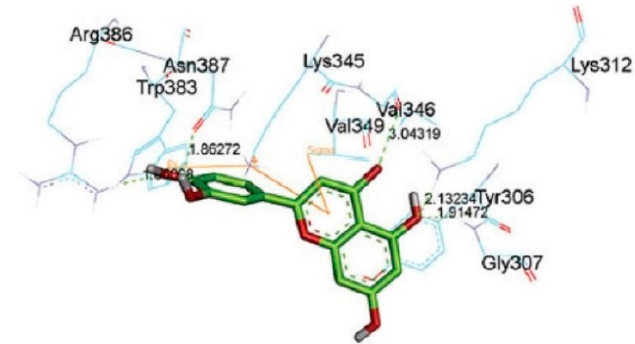
Figure 5. CMDA of a β -catenine-catechin complex. Green dotted lines and orange lines represent hydrogen bond and π interactions, respectively. Reproduced from [29] under the terms of the Creative Commons Attribution-NonCommercial-ShareAlike License.